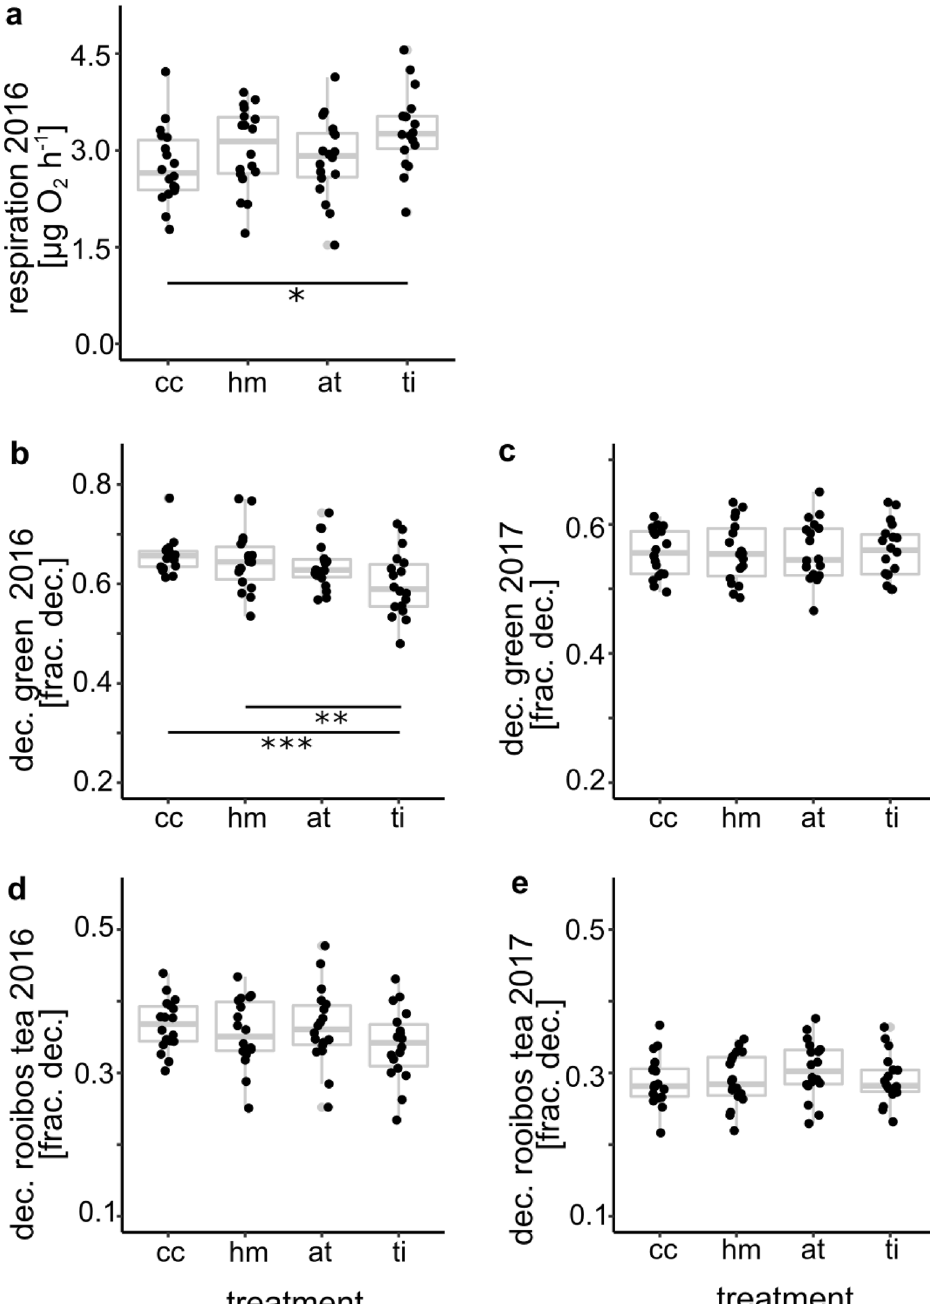
Figure 3. Response of soil functions to soil treatment types (‘cc’ complete cover, ‘hm’ herbal mixture, ‘at’ alternating tillage, ‘ti’ tillage). ( a ) soil respiration 2016, ( b, c ) decomposition of green tea 2016 ( b ) and 2017 ( c ), ( d, e ) decomposition of rooibos tea 2016 ( d ) and 2017 ( e ). Data points are represented by black dots; 25% and 75% percentile, mean, and range of data are represented by grey box-whisker plots. Horizontal bars indicate significant differences between treatments at levels p < 0.05 (*), p < 0.01 (**), p < 0.001